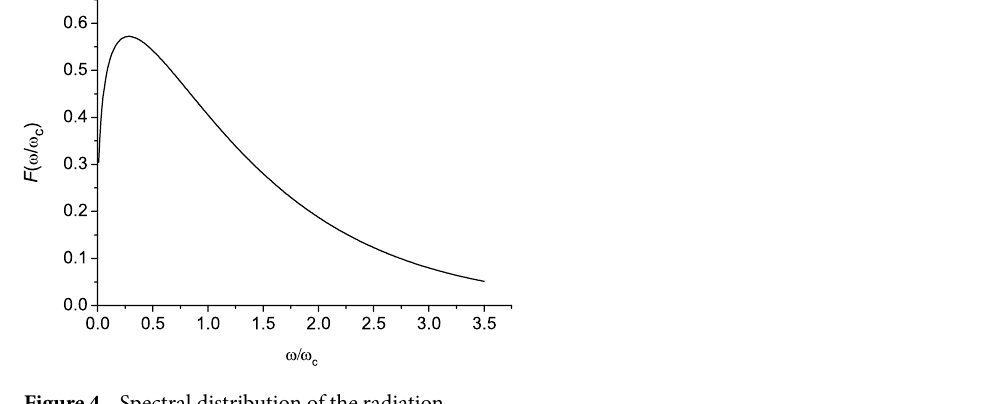
Figure 4. Spectral distribution of the